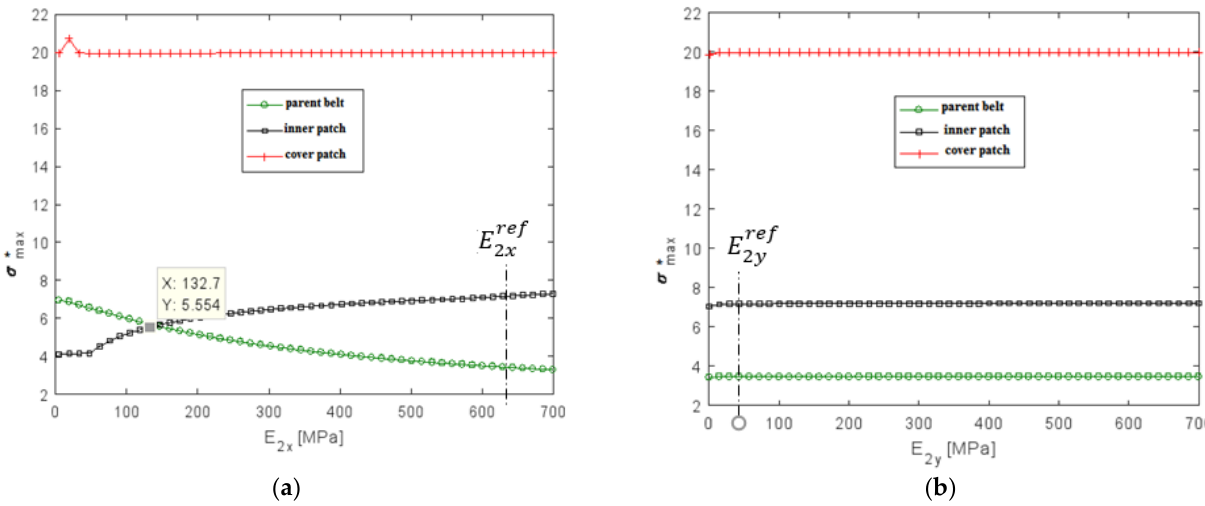
Figure 19. Variation of the maximal normalized normal stress as a function of ( a ) longitudinal Young’s modulus; ( b ) trans- verse Young’s modulus.